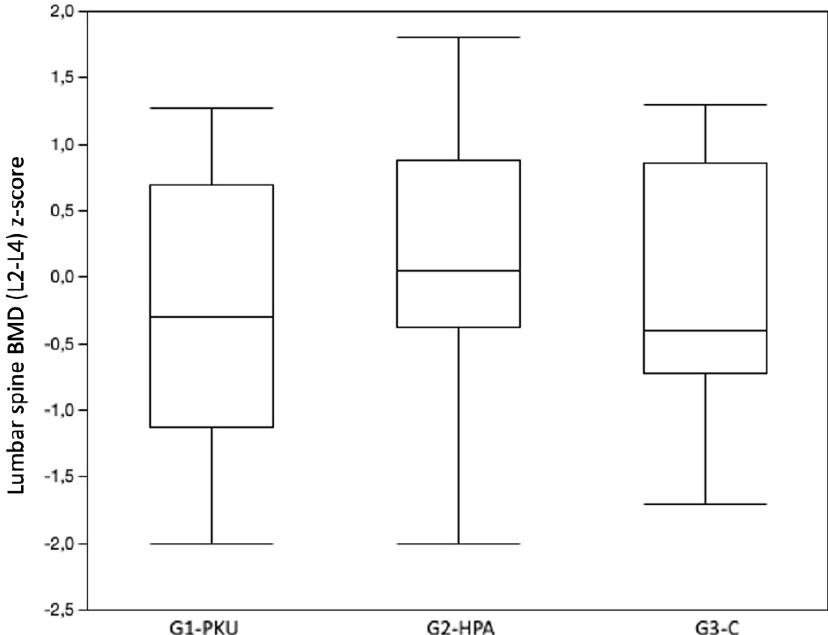
Figure 2. Z-score bone mineral density for each group. Z-score lumbar spine BMD for three groups of patients: Group 1: PKU, Group 2: HPA and Group 3: Control (n = 48). Groups were compared by Kruskal-Wallis test. The horizontal middle line represents the median and 95% confidence interval (CI). Significant difference between groups at p< 0.05. There is no significant difference between groups.